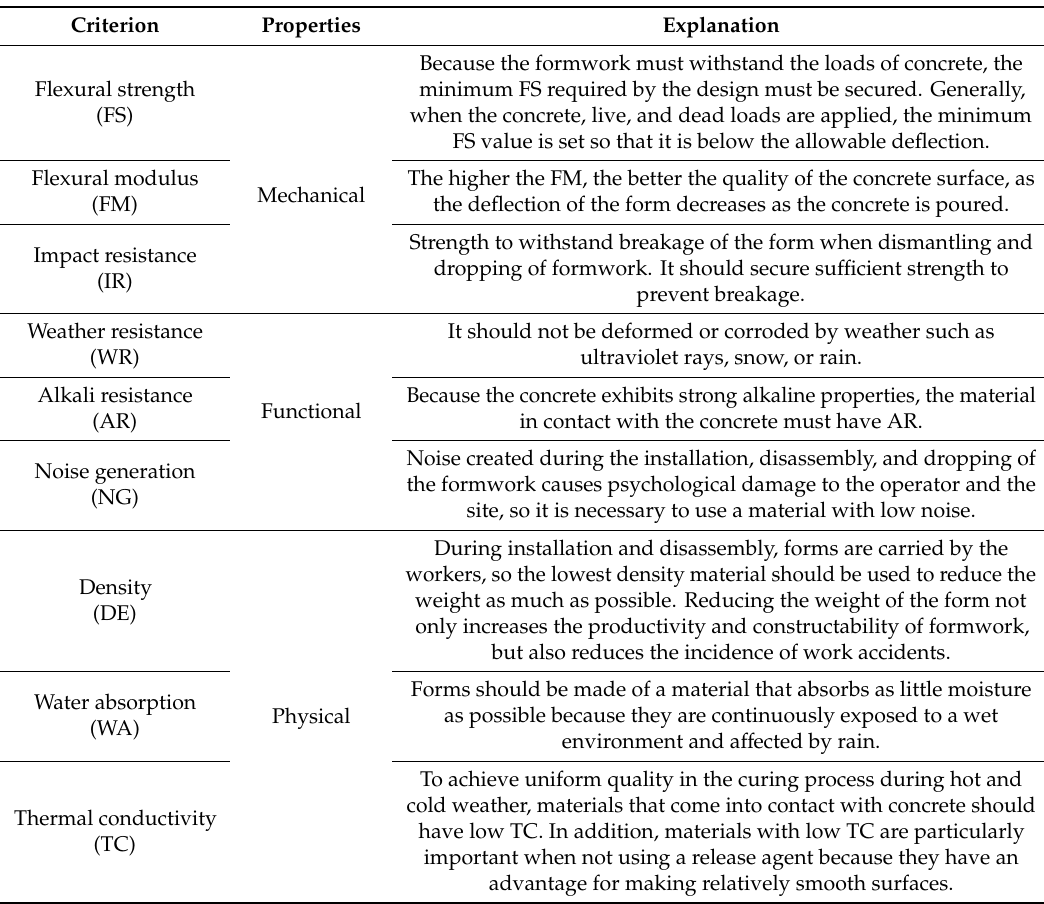
Table 2. Criteria for material selection of concrete